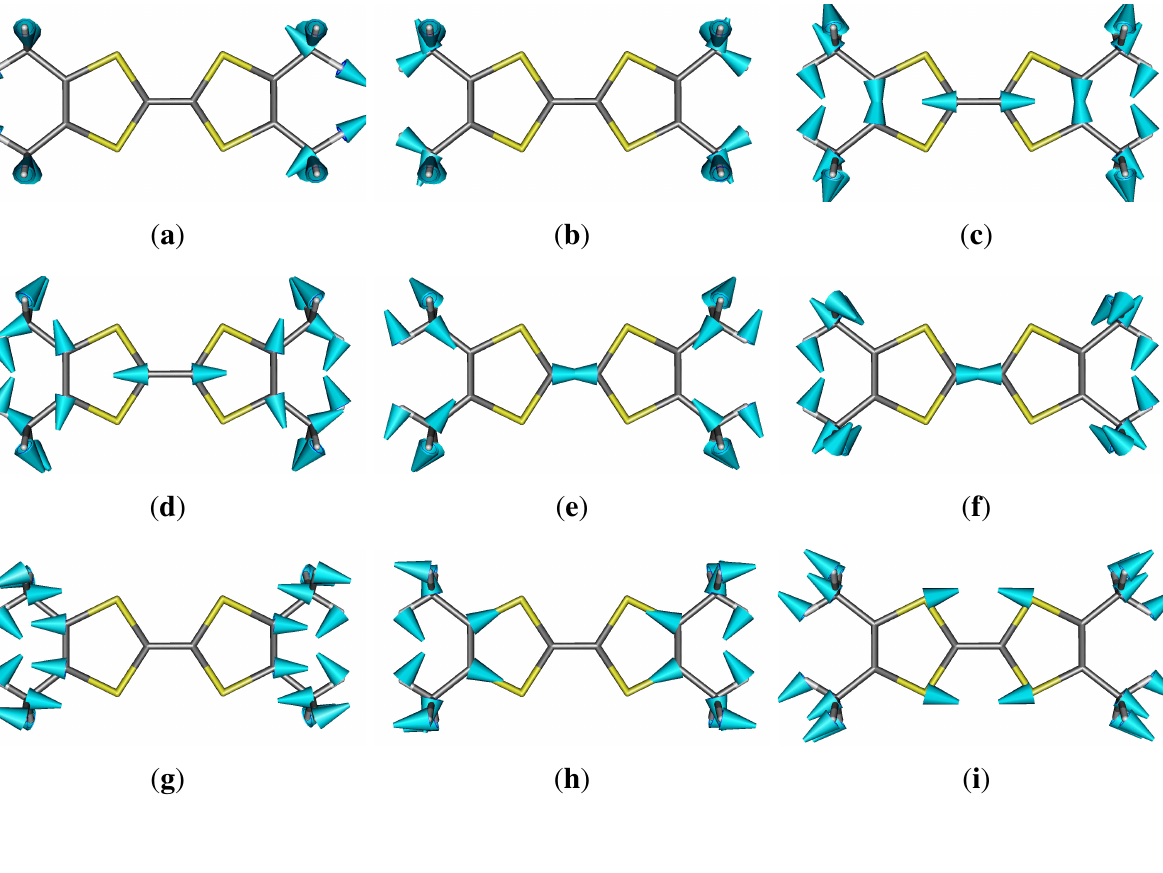
Figure A2. Eigenvectors of the twelve totally symmetric ( a